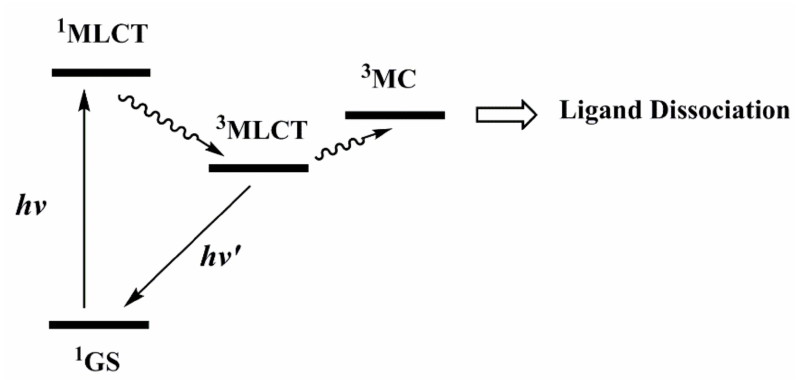
Figure 3. Jablonski diagram of Ru(II) complexes with photolabile